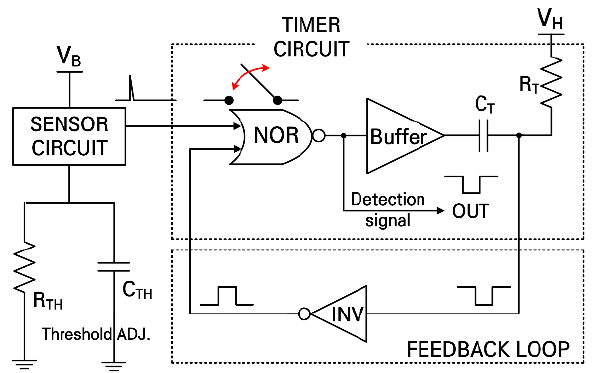
Figure 2. Block diagram of the proposed complementary metal-oxide semiconductor (CMOS) logic fast-switching pulsed-radiation detection circuit.